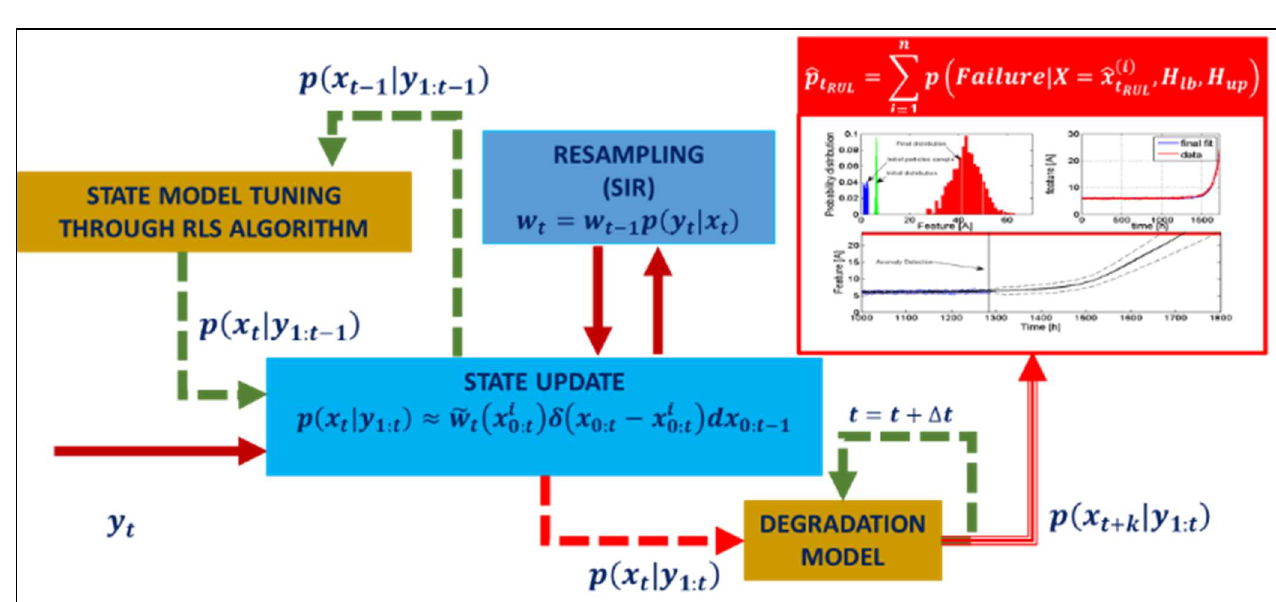
Figure 17. Scheme of the employed particle-filtering algorithm.